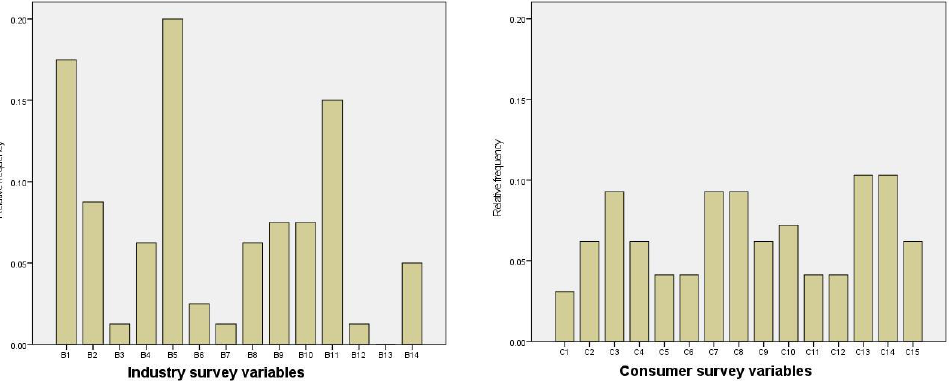
Figure 1. Bar chart with relative frequency of variable selection (industry and consumer survey).